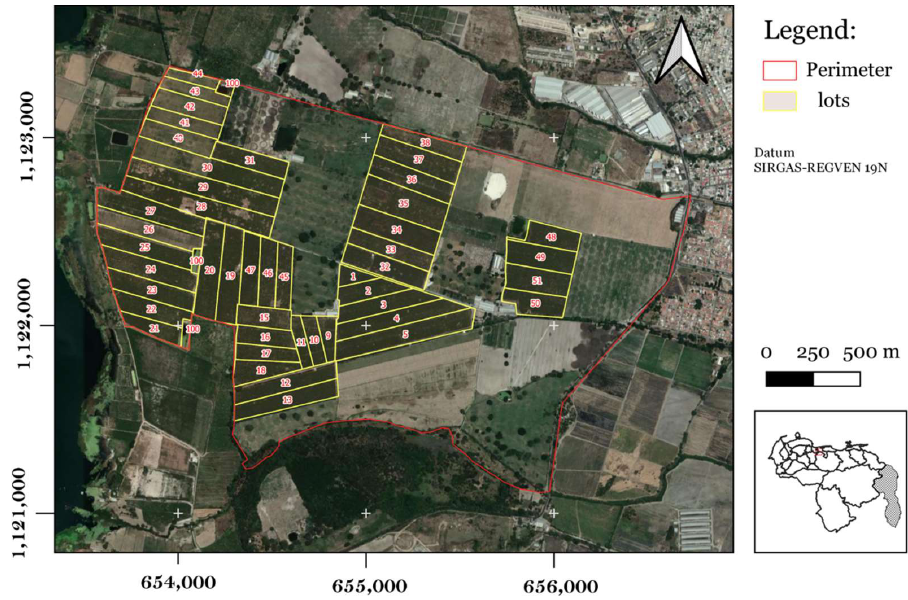
Figure 7. Geographical location of the study area with banana lots (marked with yellow color boundaries).